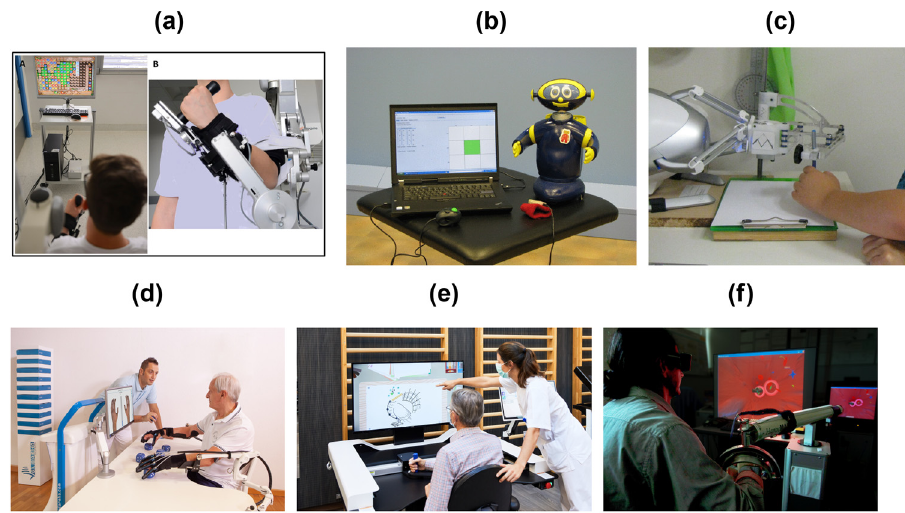
Figure 2: ( a ) ArmeoSpring ( Hocoma AG, Volketswil, Switzerland ) ( ©Emilia Bi ffi ) , ( b ) CosmoBot ( AnthroTronix, Inc, Silver Spring, MD, US ) [ 42 ] ( ©IEEE ) , ( c ) Falcon Haptic device ( Novint Technologies Inc., Albuquerque, NM, US ) ( ©: Pamela Hood Szivek ) , ( d ) Gloreha Sinfonia ( Indrogent, Lumezzane, Italy ) ( ©Indrogent ) , ( e ) REAplan ( Axinesis, Wavre, Belgium ) ( ©Axinesis ) , ( f ) Haptic Master ( Moog, The Netherlands ) ( ©Qinyin Qiu )